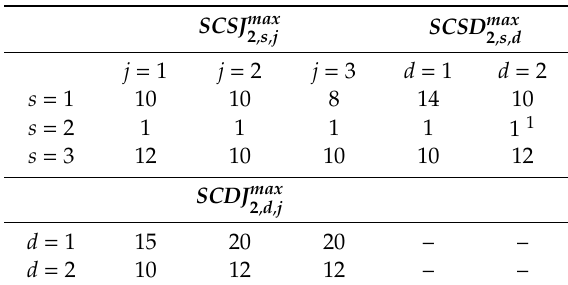
Table A19. Maximum loading capacity per shipment of product 2 (units).